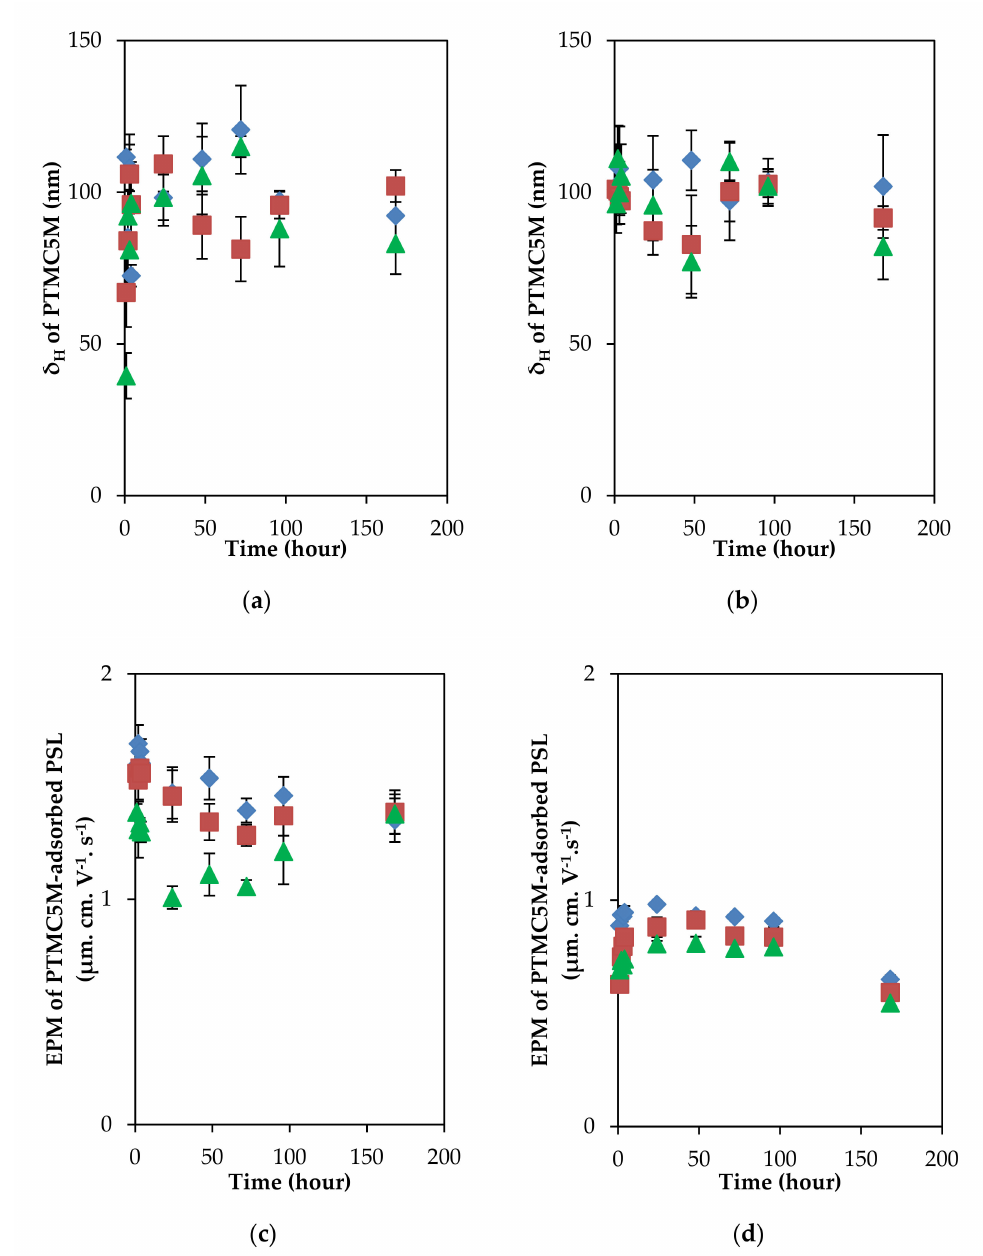
Figure 4. δ H and EPM of PTMC5M–adsorbed PSL colloidal particles as a function of time lapse under two ionic strength conditions. In 0.1 mM KCl: ( a ) δ H , ( c ) EPM and in 10 mM KCl: ( b ) δ H , ( d ) EPM. Initial PTMC5M concentrations: 10 ppm ( (cid:7) ), 5 ppm ( (cid:4) ), 2 ppm ( (cid:78) ). The deviations of different runs are shown by the error bars